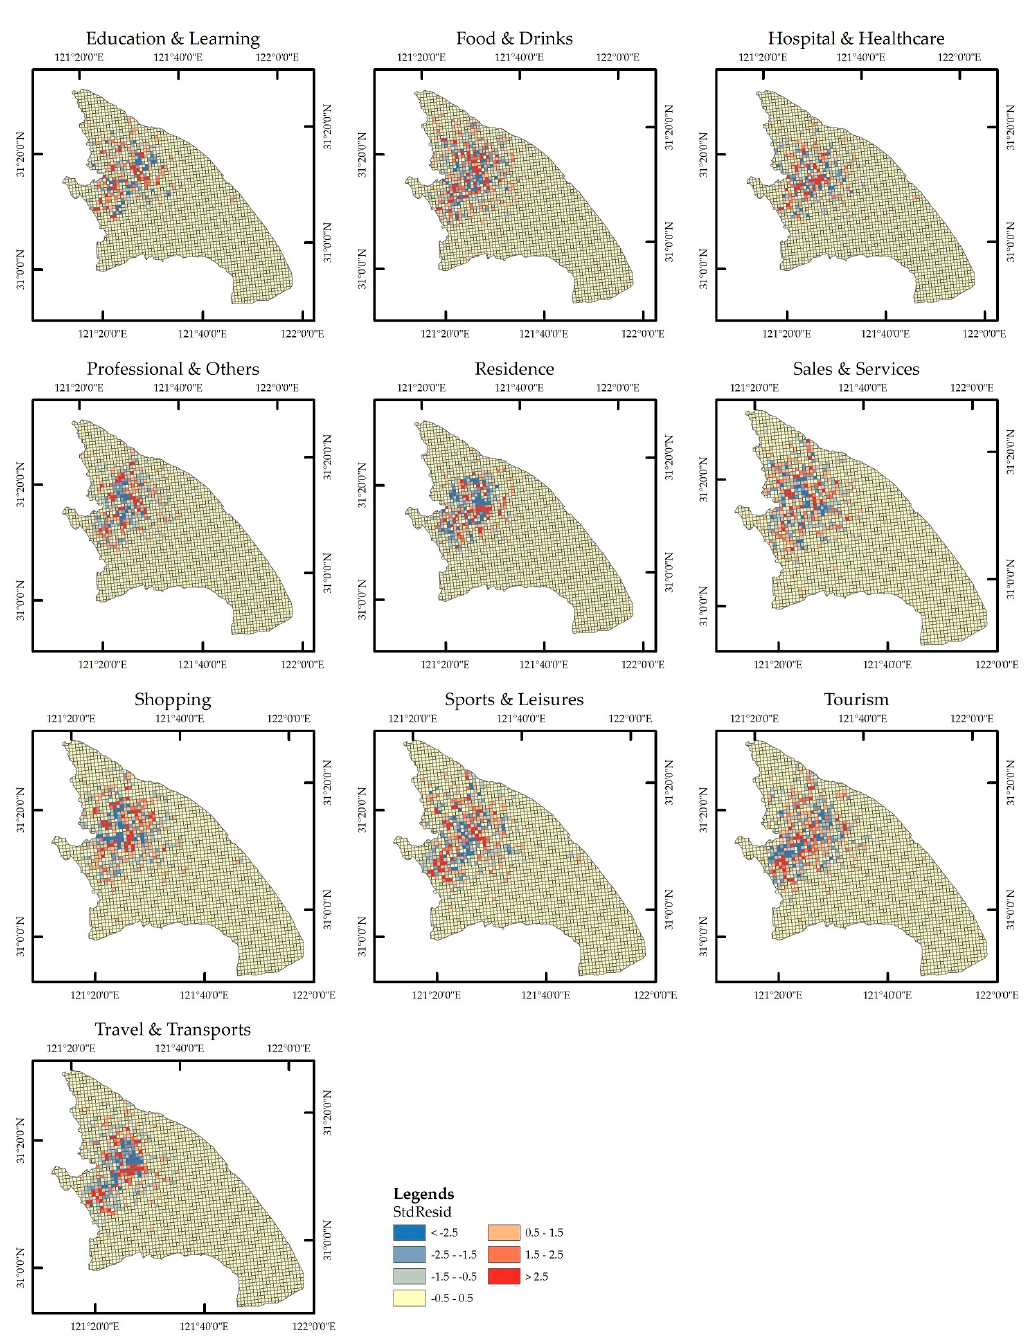
Figure 14. Spatial distribution of activities by the women in Shanghai.